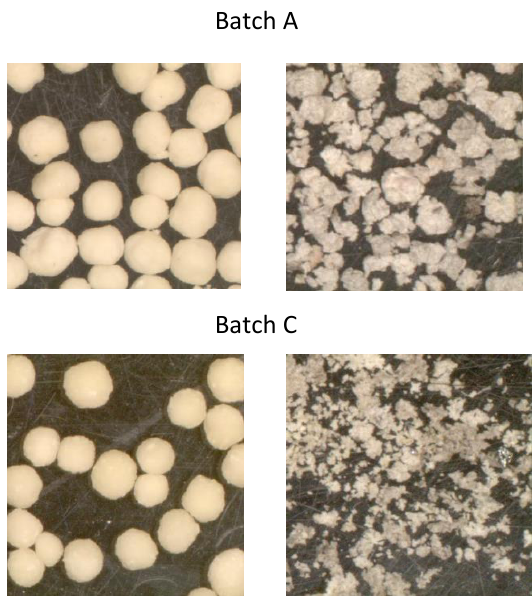
Figure 9 . Images of pellets of batches A, C before (left) and after (right) dissolution testing at pH 1.2.